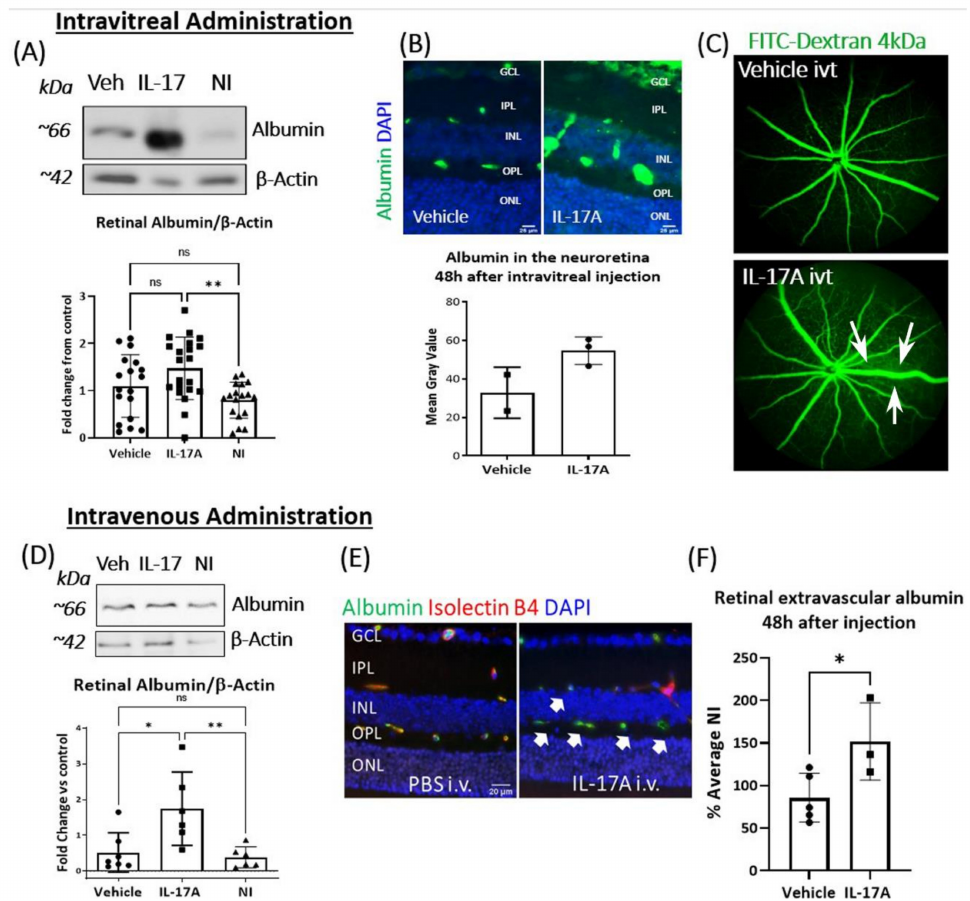
Figure 2. The effect of IL-17A in BRB integrity in vivo. Retinal albumin expression and albumin leakage were assessed 48 h after IL-17A intravitreal (itv, A – C ) or intravenous (i.v., D – F ) administration in C57BL/6J mice. ( A ) Western blot analysis of total albumin expression in the retina from vehicle (Veh, PBS) or IL-17A ivt, and control mice (no injection). Corresponding densitometry of albumin normalized to β -Actin. n ≥ 16 retinas from n ≥ 8 mice per group. ( B ) Albumin immunostaining (green) in retinal sections from IL-17A or PBS ivt mice. Scale bar = 25 µ m. Graph showing mean gray value of albumin in the neuroretina ( n ≥ 2 animals per group). ( C ) Representative images showing FITC-Dextran leakage from retinal vessels 48 h after IL-17A or PBS control ivt. White arrows: FITC-Dextran leakage, n ≥ 4 eyes per group. ( D ) Western blot analysis of total albumin expression in the retina from vehicle (Veh, PBS) or IL-17A i.v. and control mice (no injection); n ≥ 6 retinas from n ≥ 6 animals per group. ( E ) Representative images of extravascular albumin (green) outside Isolectin B4 + blood vessels (red) in the retina from PBS or IL-17A i.v. injected mice. White arrows: albumin leakage. ( F ) Quantification of extravascular albumin in the retina from vehicle or IL-17A i.v. injected mice. Blue—DAPI; n ≥ 3 eyes per group. Scale bar = 20 µ m. Mean ± SD; ** p < 0.001, * p < 0.05 with One-Way ANOVA followed by Dunnett’s multiple comparisons in A and D and unpaired t -test in ( F